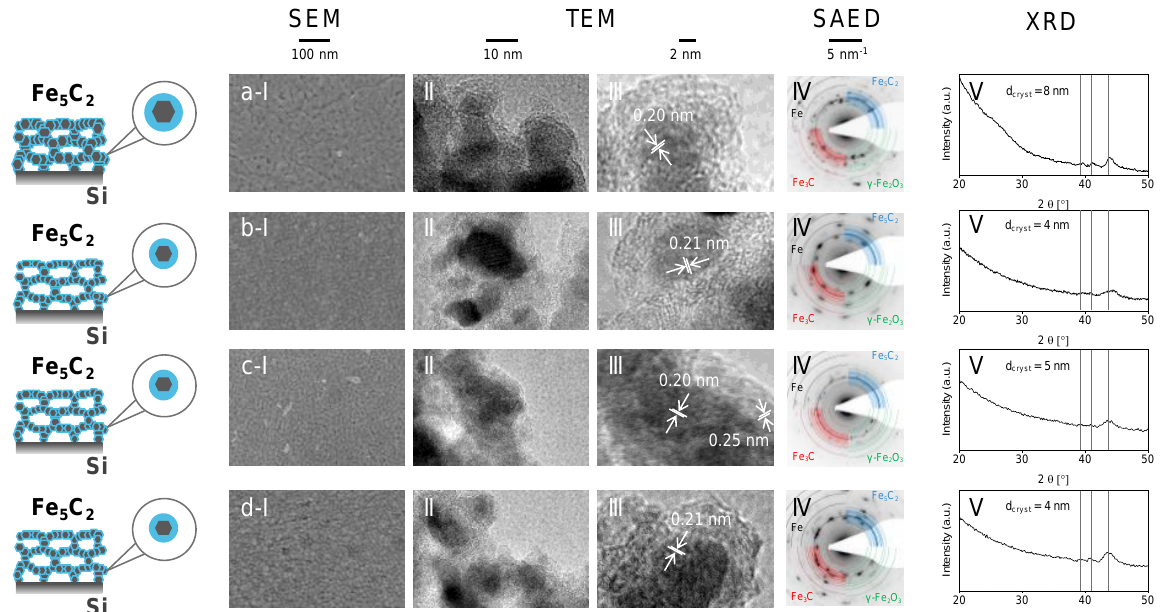
Figure 2. Physicochemical analysis for mesoporous iron oxide films after treatment in CO/H 2 (2 to 1) flowrate 372 mL/min at 300 ◦ C for 20 h. ( a ) HEM, ( b ) FH, ( c ) MAGH, and ( d ) MAGH/MAGN. All samples were characterized by (I) SEM, (II/III) TEM, (IV) SAED, and (V) GI–XRD.